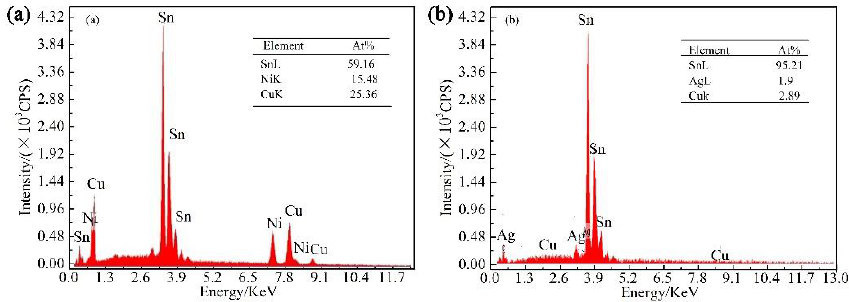
Figure 12. EDS analysis of Sn2.5Ag0.7Cu0.1RExNi / Cu soldering joint under thermal-cycle loading. ( a ) A area in Figure 11(c); ( b ) B area in Figure 11(c).